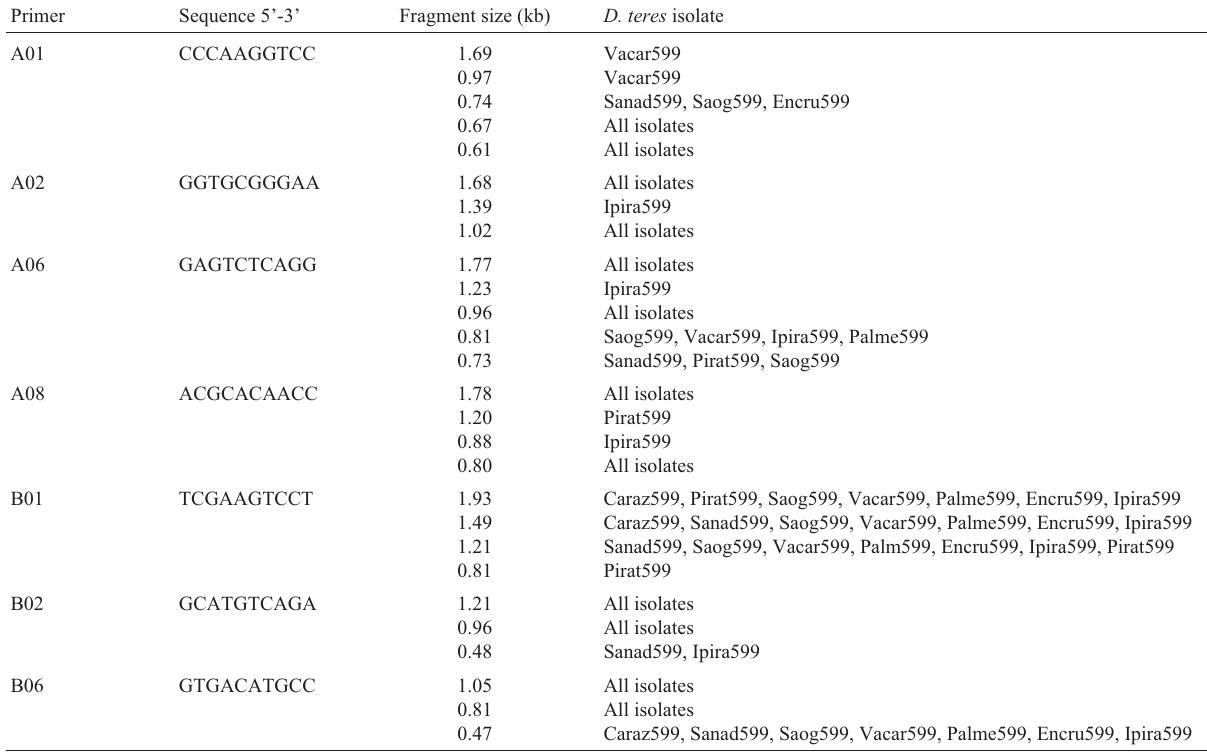
Table II - Sequences of the 16 primers used in this study and size in kilobases (kb) of the amplified Drechslera teres DNA fragment.